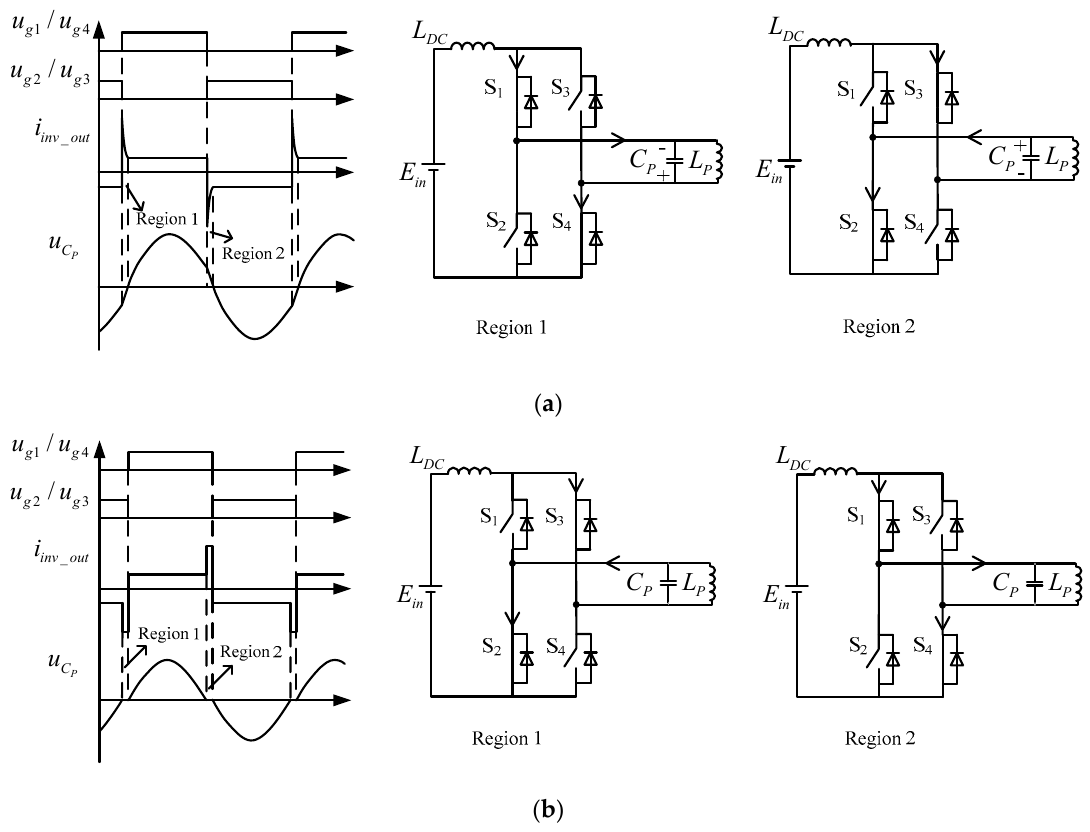
Figure 4. Short current analysis in a Current-Fed IPT system: ( a ) Capacitive case, f S < f r